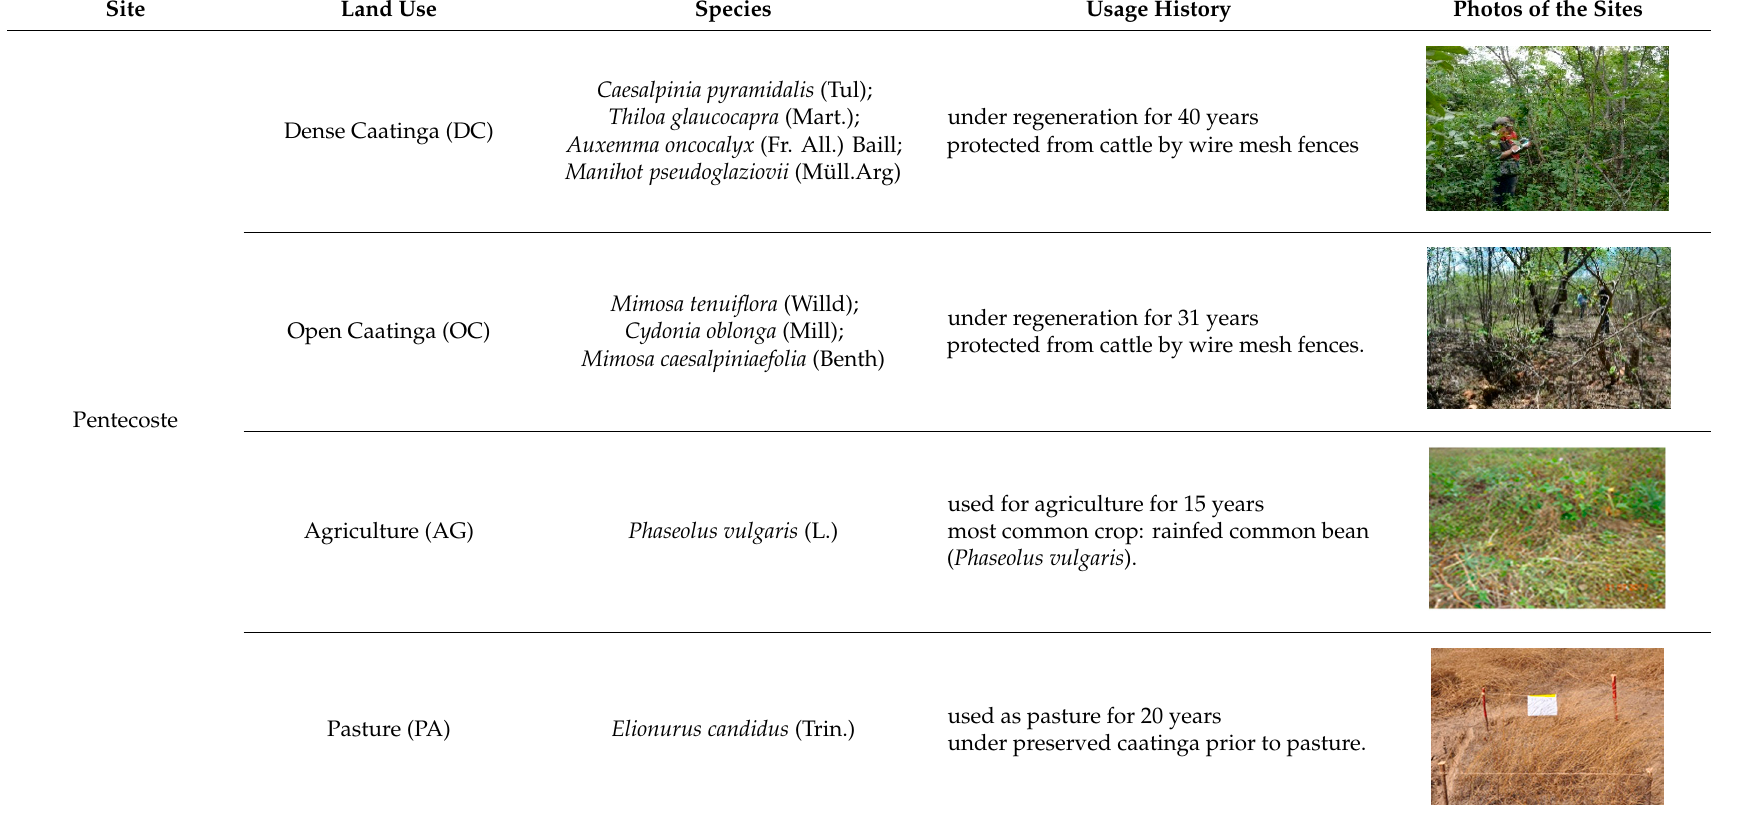
Table 1. Land-use description at the three sites under study.